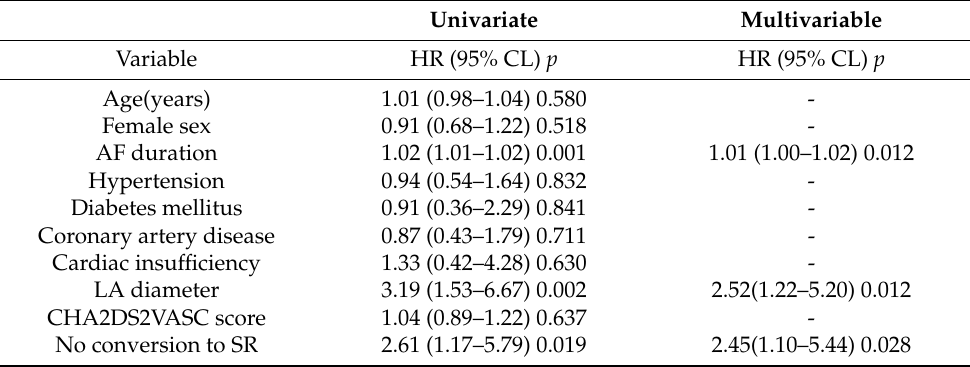
Table 4. Predictors of recurrence at follow-up in Cox regression analysis. Univariate